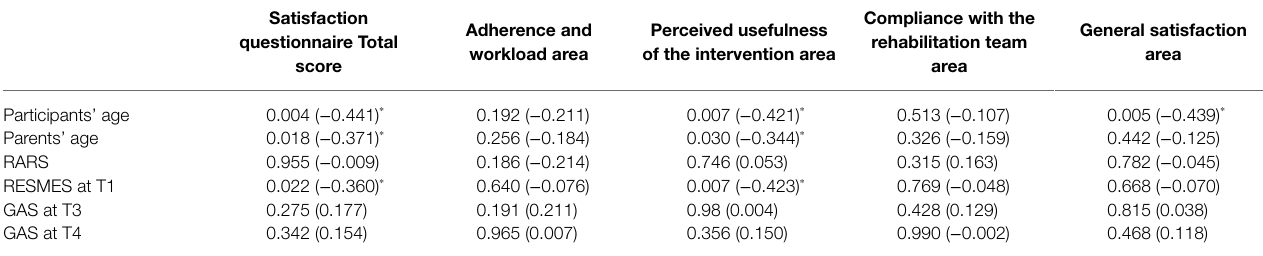
TABLE 3 | Output of Spearman rank correlation coefficient analysis between the satisfaction questionnaire total and individual area scores and RTT severity level (measured with RARS), level of motor functional abilities (evaluated with RESMES at T1), level of therapeutic goals achievement [measured with Goal Attainment Scaling (GAS) at T3 and T4], and parents’ and participants’